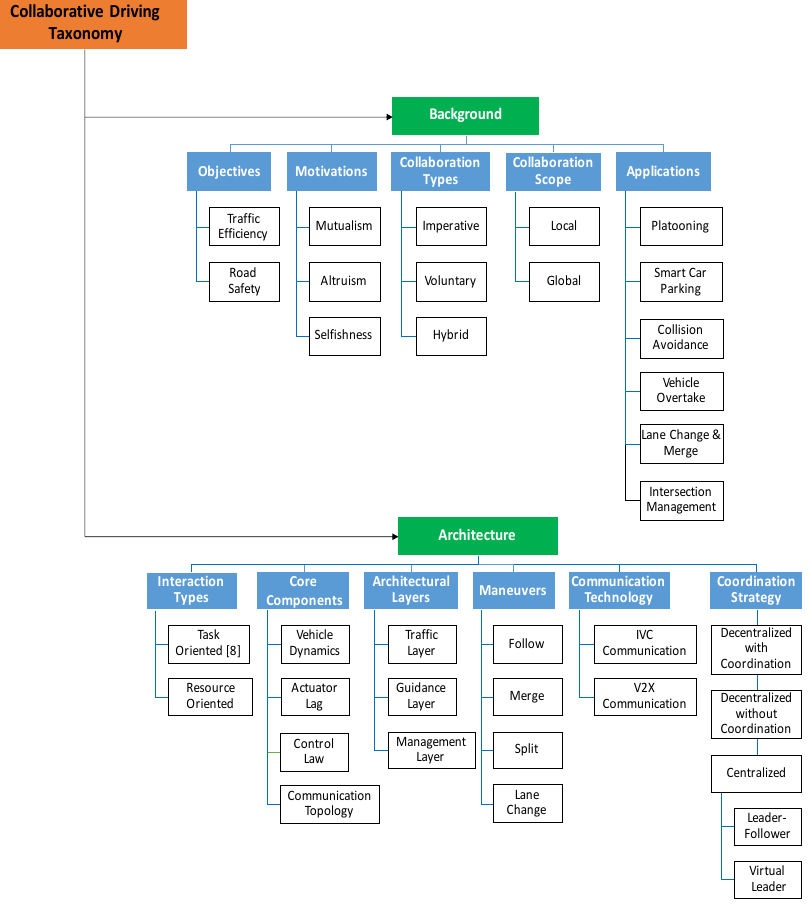
Figure 1. Collaborative driving system (CDS)